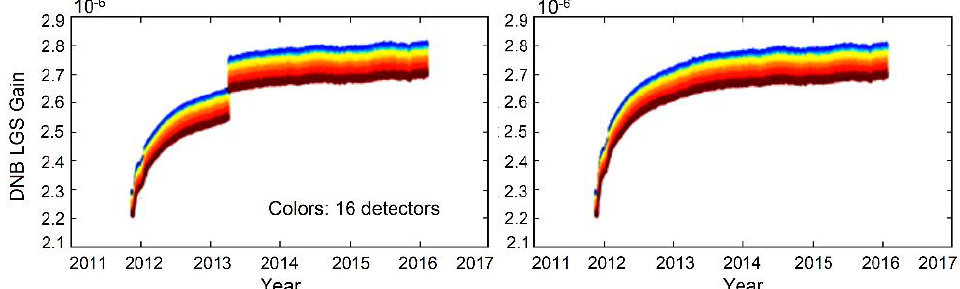
Figure 8. DNB low-gain stage (LGS) gain trends for the aggregation zone #1 (around nadir). ( Left) Operational calibration showing discontinuity in LGS gain by using only one update in RSR on 4 April 2013. ( Right ) Recalibration showing smooth LGS gain trend after using continuous sets of time-dependent relative spectral responses (RSRs) [54].